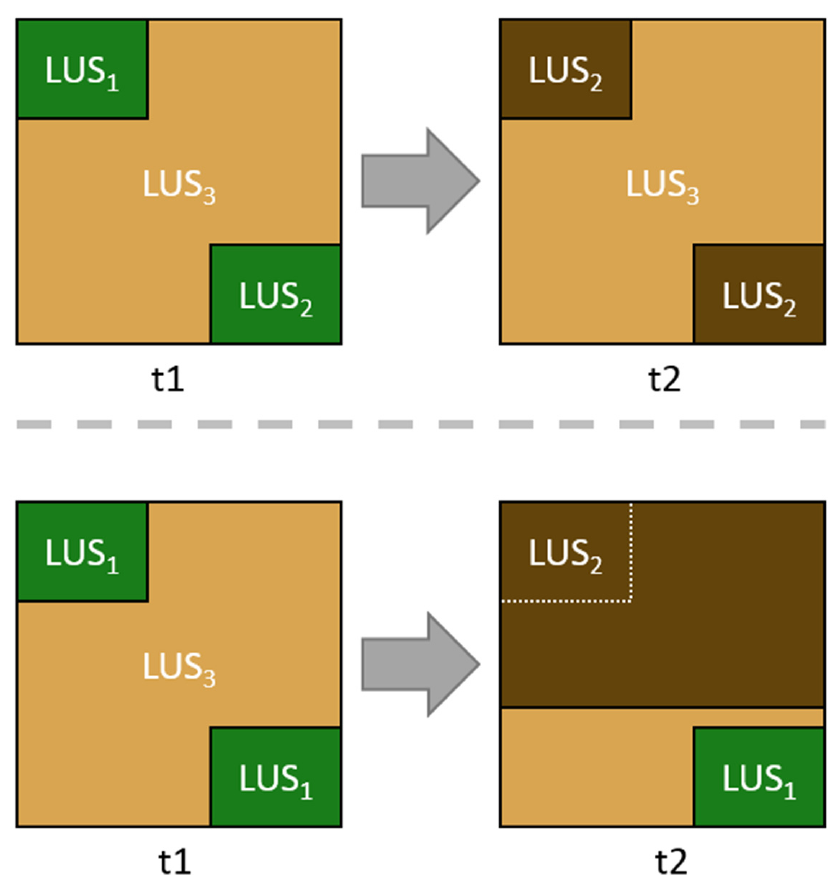
Figure 2. Correspondence and non-correspondence of prospective and retrospective analysis. Upper part: Loss of LUS 1 entirely in favor of LUS 2 , while LUS 2 is established entirely at the cost of LUS 1 (prospective analysis matches retrospective analysis). Lower part: Loss of LUS 1 entirely in favor of LUS 2 , while LUS 2 is predominantly established at the cost of LUS 3 (the prospective analysis does not match retrospective analysis).